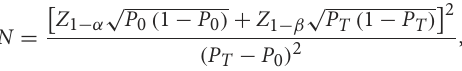
Abbreviations: RDR, referable diabetic retinopathy; RMD, referable macular diseases; GCS, glaucoma suspect; CI, confidence interval; AUC, area under the receiver operating characteristic